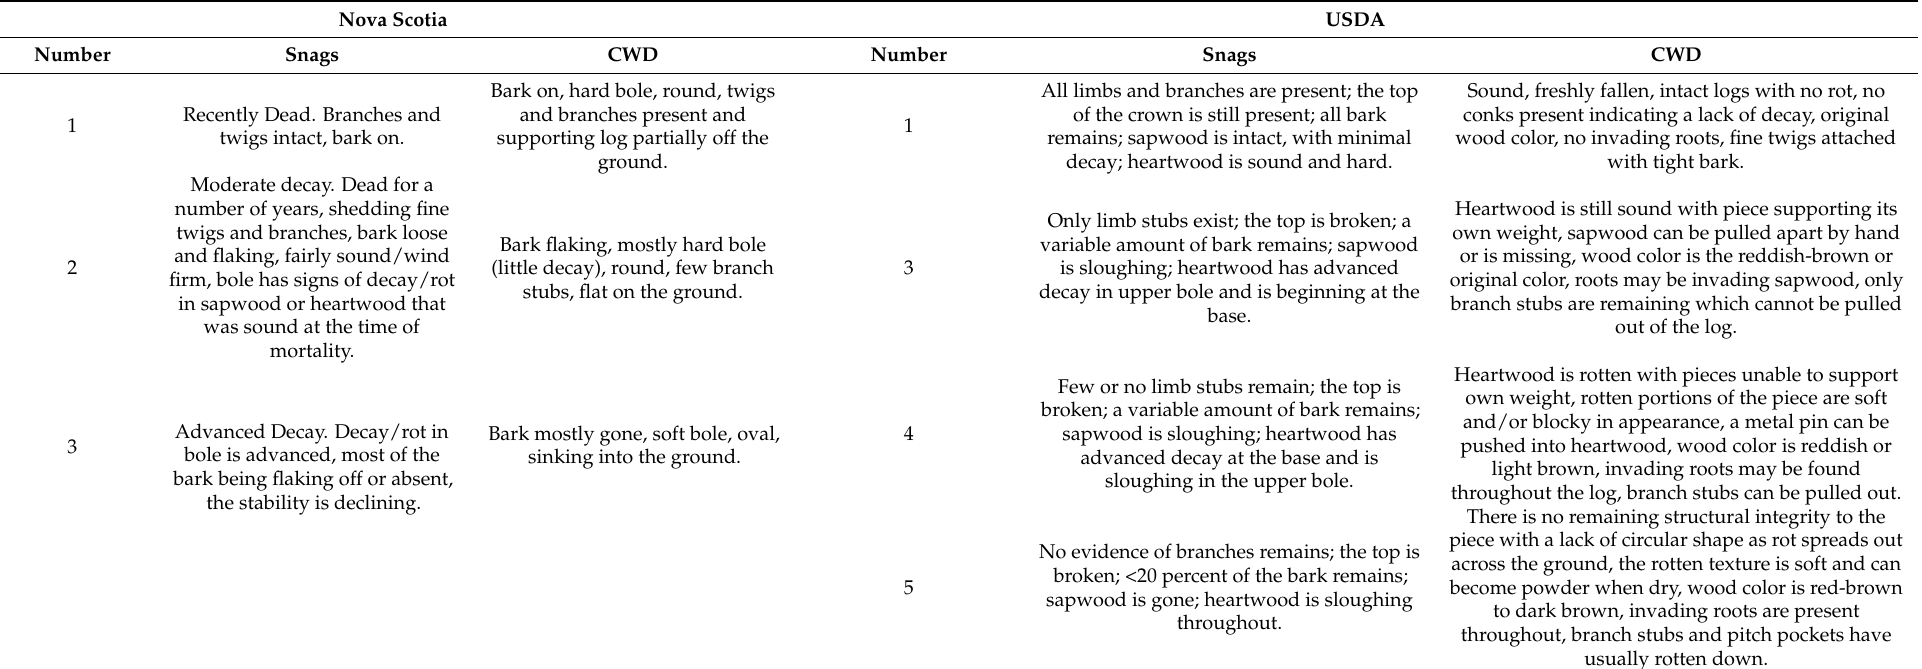
Table A1. Nova Scotia (NS) decay class number and description for standing dead or snags and coarse woody debris (CWD) [45] and their equivalent USDA classes [14] *. This Table was created for this study, the text is a direct quotation from the Nova Scotia Department of Lands and Forestry [45] and USDA Forest Service